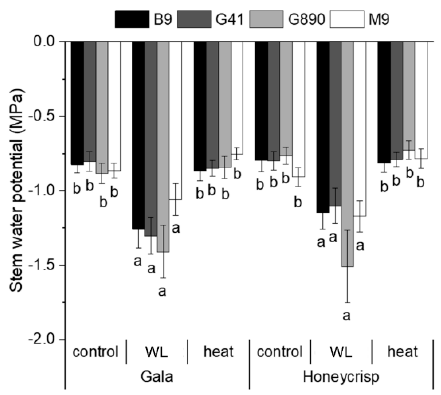
Figure 3. Mean mid-day stem water potential (MPa) for ‘Gala’ and ‘Honeycrisp’ apple cultivars grafted on B9, G41, G890, and M9 rootstocks grown under water-limited (WL) or elevated soil temperature treatments compared to an untreated control. Error bars denote standard error ( n = 3). Letters denote significant differences among means determined using a Tukey’s mean separation test ( α = 0.05).